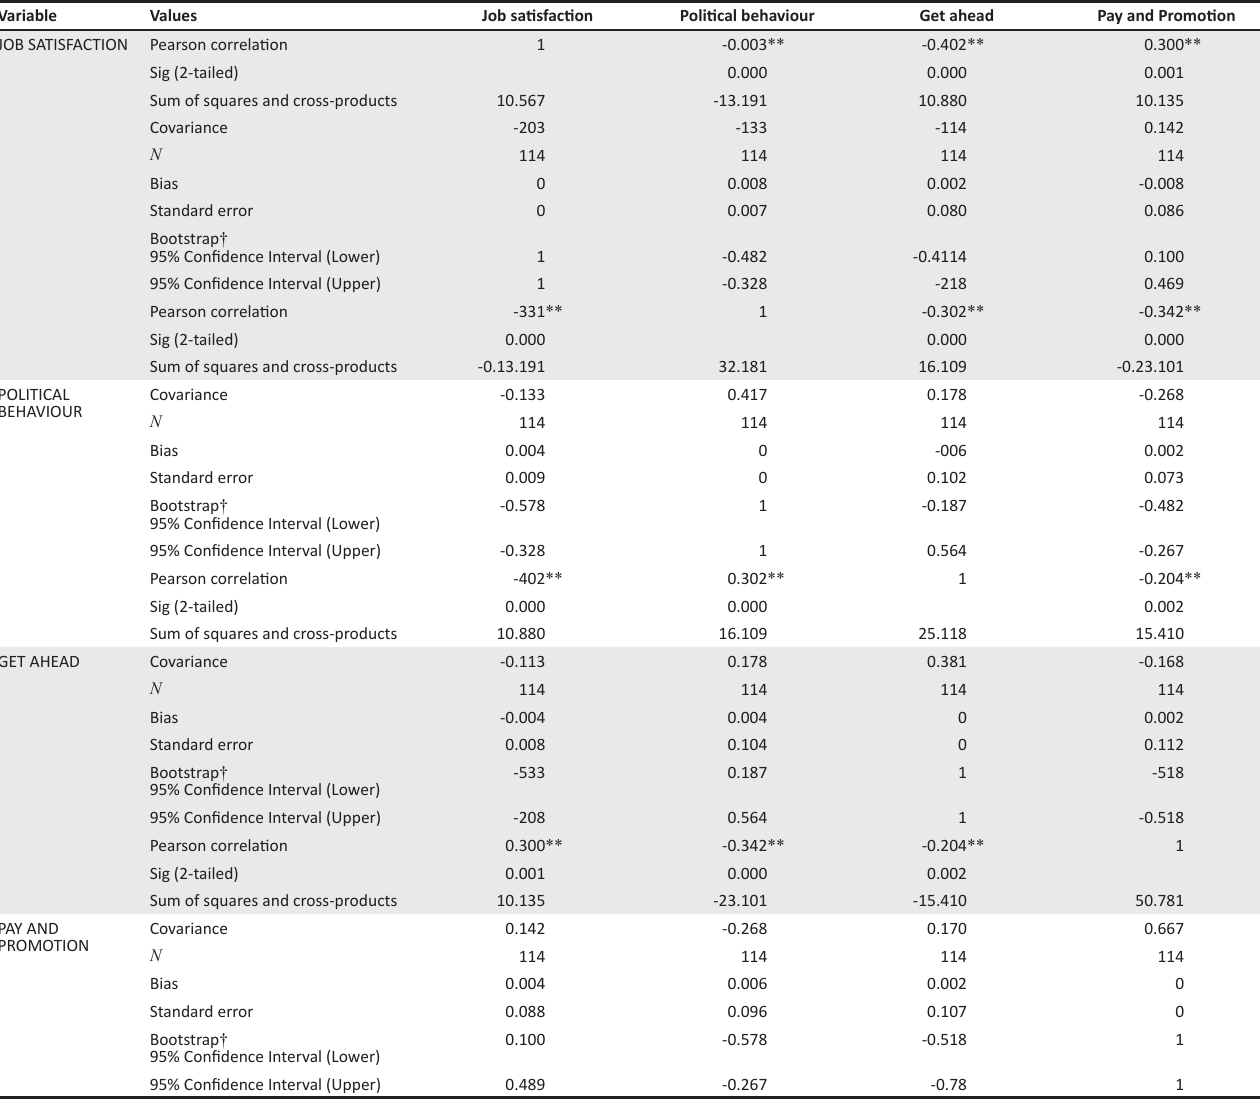
TABLE 3: Inferential statistics on the relationship between the perceptions of organisational politics related to general pollical behaviour, get ahead and pay and promotion policies and job satisfaction. Variable Values Job satisfaction Political behaviour Get ahead Pay and Promotion JOB SATISFACTION Pearson